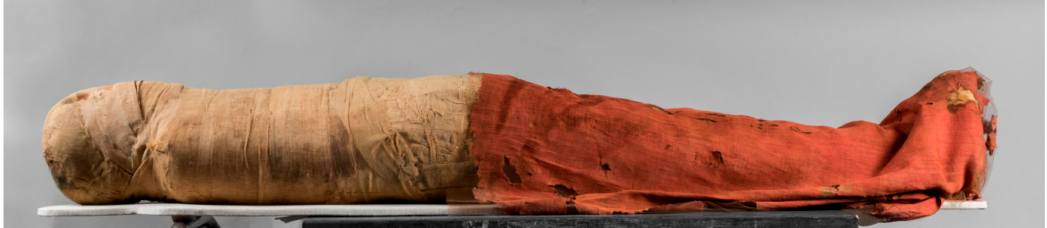
Figure 1. The red shroud partially covering the mummy of Nesamonendjam (registration number: Suppl. 5227 / 2; photo: Museo Egizio, Torino,